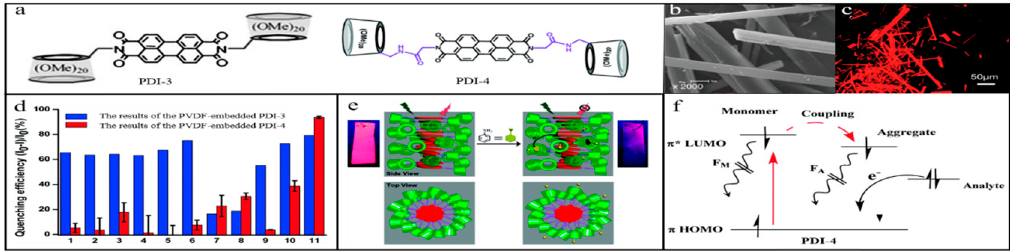
Figure 6. ( a ) Molecular structures of PDI-3 and PDI-4; ( b , c ) SEM and fluorescence optical image of PDI-3 nanorods; ( d ) Fluorescence quenching efficiency measured over the PVDF-embedded films of PDI-3 and PDI-4 upon 10 s of exposure to the saturated vapors of various amines, nitro-based compounds, and general organic solvents: 1, toluene; 2, methanol; 3, chloroform; 4, nitromethane; 5, nitroethane; 6, acetonitrile; 7, hydrazine hydrate; 8, benzylamine; 9, triethylamine; 10, butylamine; 11, aniline. Error bar: standard deviation of measurement; ( e ). Schematic illustration of the aggregation morphology of PDI-4 on PVDF and its sensing process for aniline; ( f ). Energy level diagram showing the direction and driving force for PET between analyte and PDI-4 in both molecule and aggregate state [63,64].